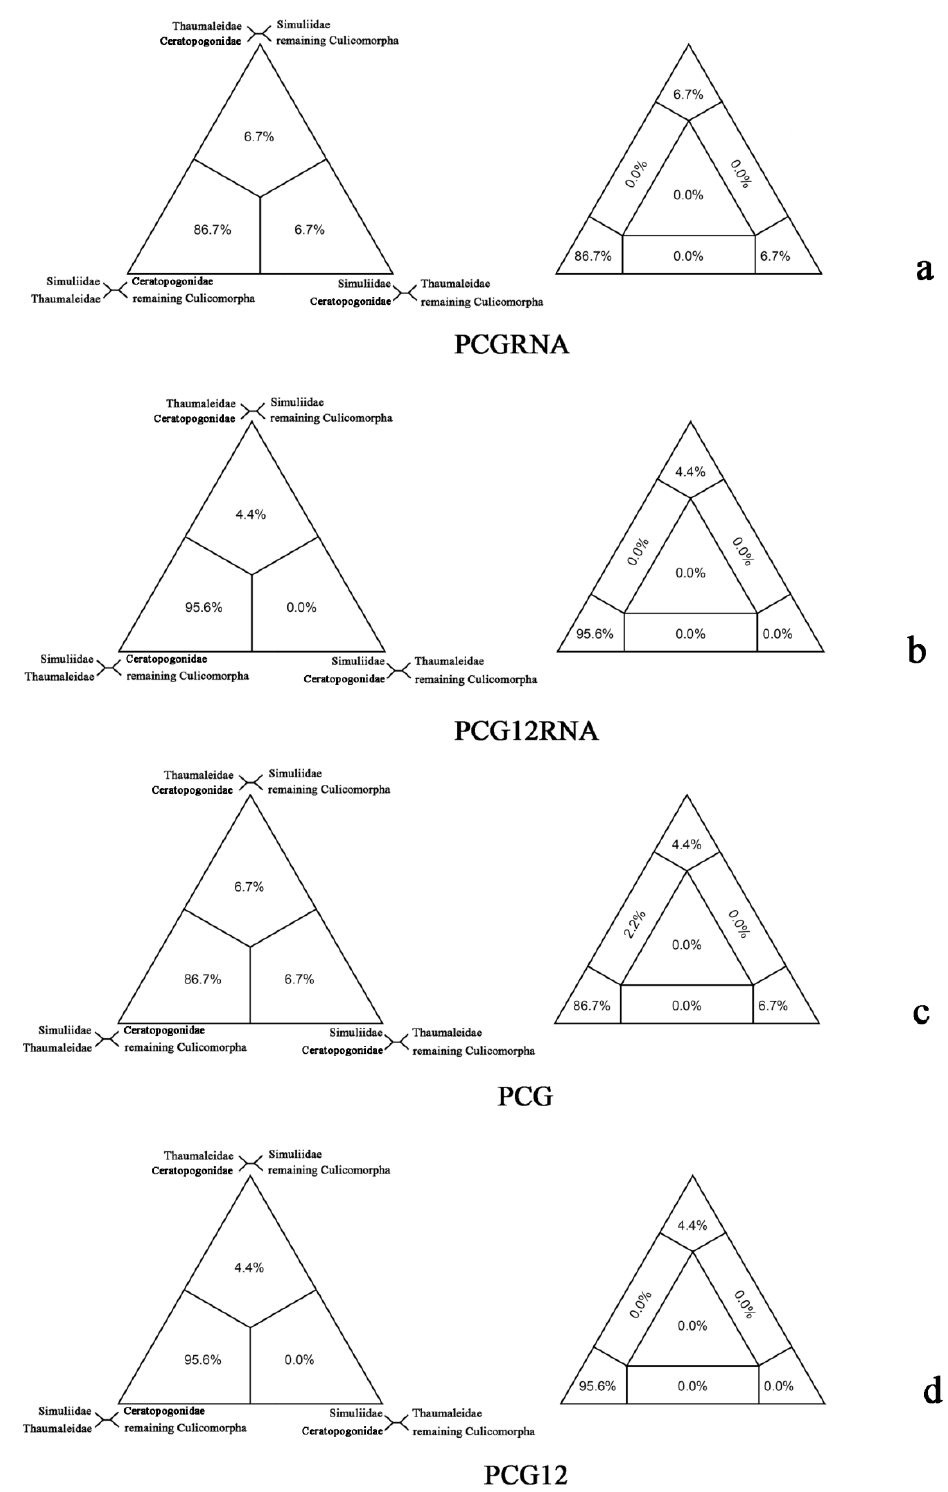
Figure 2. Results of Four-cluster Likelihood Mapping as 2D simplex graphs. ( a ) Four-cluster Likelihood Mapping based on PCGRNA; ( b ) four-cluster Likelihood Mapping based on PCG12RNA; ( c ) four-cluster Likelihood Mapping based on PCG; ( d ) four-cluster Likelihood Mapping based on PCG12.